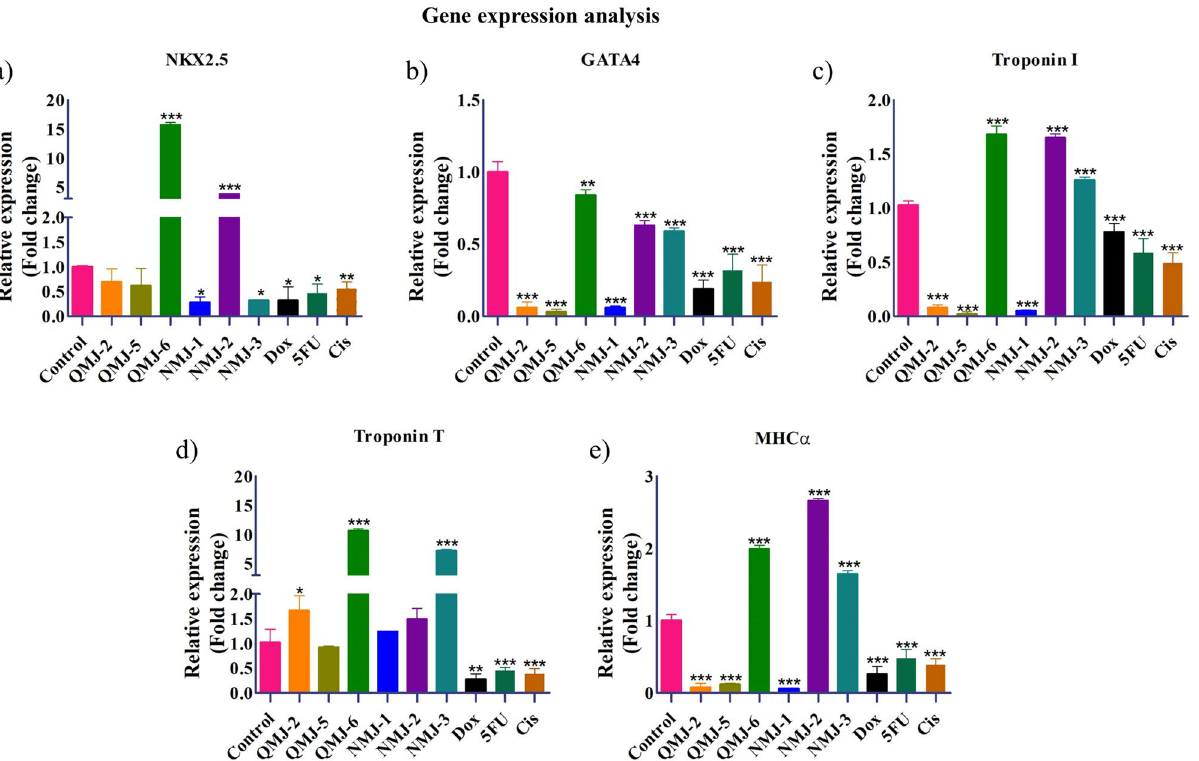
Figure 5. Gene expression analysis by qRT-PCR of cardiac-specific markers. WJCM treated with QMJ-2,- 5,-6 and NMJ-1,-2,-3 were analysed for ( a ) NKX2.5, ( b ) GATA4, ( c ) Troponin I, ( d ) Troponin T, and ( e ) MHCα. Data represented as mean ± SEM (n = 3), *p < 0.033, **p < 0.002, ***p < 0.001. Dox doxorubicin, 5FU 5-fluorouracil, Cis